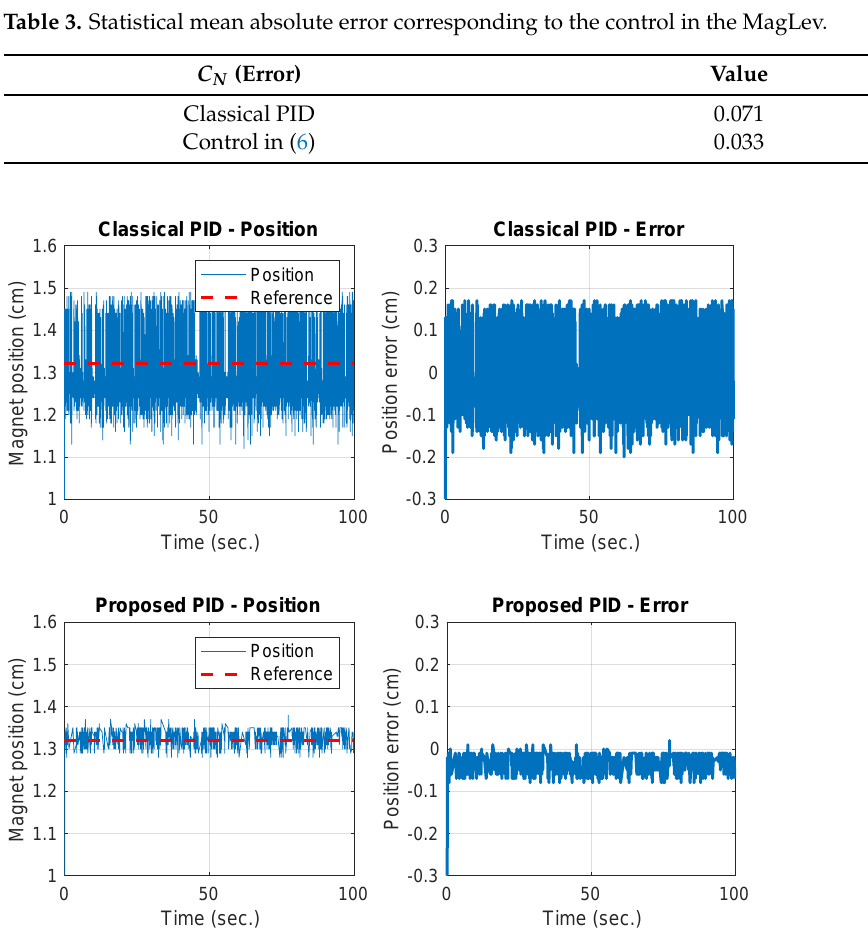
Figure 7. Experimental data from the MagLev. The upper figures show data from the classical PID control (7), and the lower figures show data from the anti-windup control (8), with parameter values presented in Table 2 (see Remark 1 for further